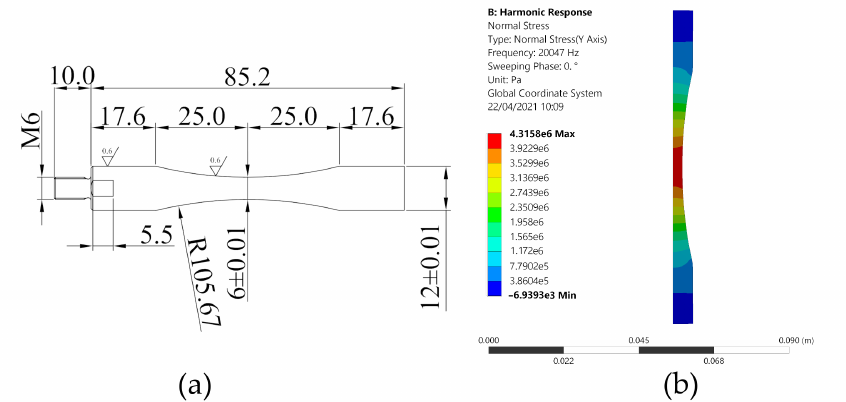
Figure 4. Specimen of 6 mm in diameter: ( a ) specimen geometry; ( b ) results of the numerical analysis.